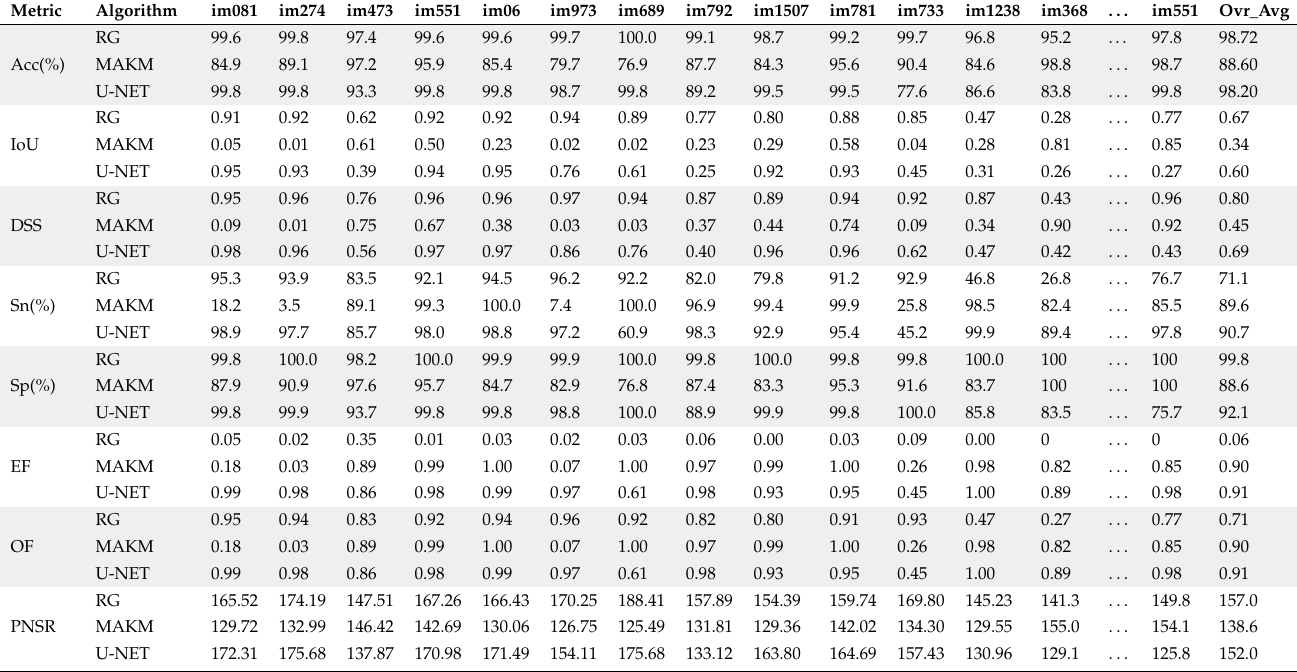
Table 4. Performance comparison of RG with MAKM and U-Net for 800 brain images from BRATS2015 Dataset.